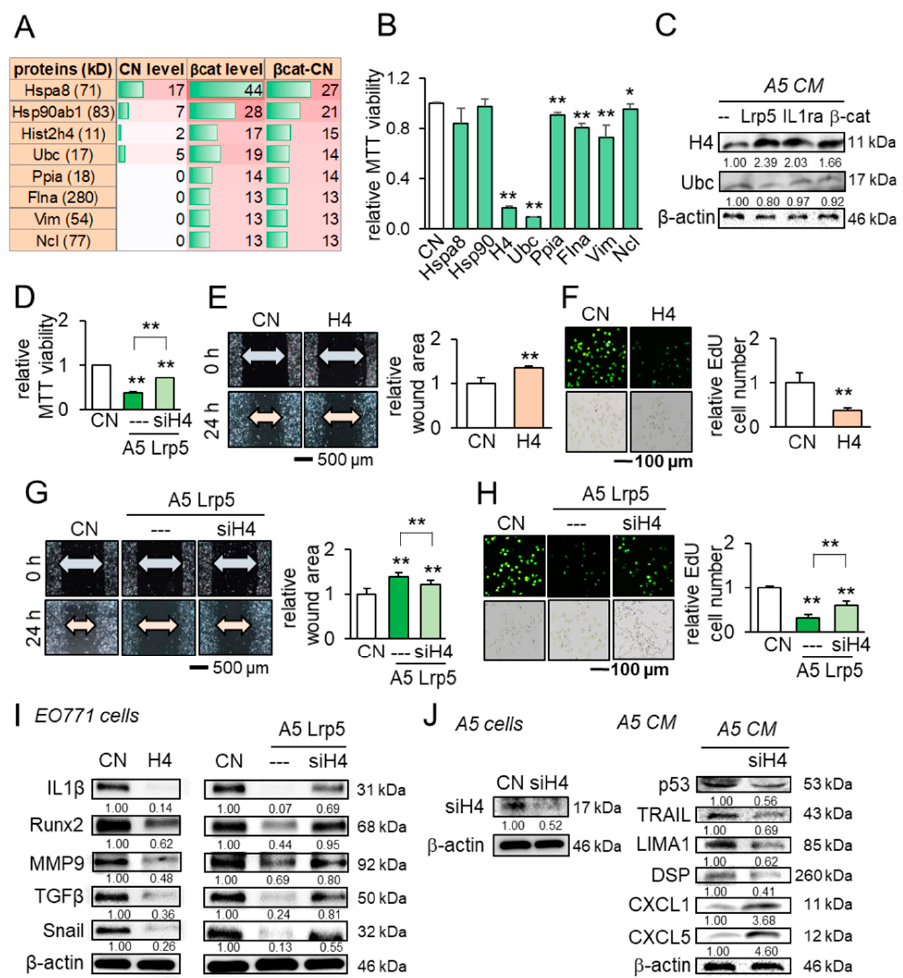
Figure 7. Anti-tumor actions of osteocyte-derived conditioned medium and the tumor-suppressing role of histone H4 in EO771 mammary tumor cells. CN = control, CM = conditioned medium, H4 = histone H4, and siH4 = histone H4 siRNA. The single and double asterisks indicate p < 0.05 and p < 0.01, respectively. The error bar indicates a standard deviation. ( A ) Eight tumor-suppressing protein candidates, predicted by whole-genome proteomics. ( B ) Effects of the predicted candidates on the MTT-based viability of EO771 mammary tumor cells. ( C ) Elevation of histone H4 in osteocyte- derived CM by the overexpression of Lrp5, IL1ra, and β -catenin. ( D ) Reduction in MTT-based viability by histone H4 and its suppression by histone H4 siRNA. ( E , F ) Reduction in the scratch-based migration and EdU-based proliferation by histone H4. ( G , H ) Suppression of the reduced migration and proliferation by histone H4 siRNA. ( I ) Reduction in IL1 β , Runx2, MMP9, TGF β , and Snail by histone H4, and the suspension of their reduction by histone H4 siRNA. ( J ) Silencing of histone H4, and Reduction in p53, TRAIL, LIMA1, and DSP, as well as the elevation of CXCL1 and CXCL5 in osteocyte-derived CM by histone H4